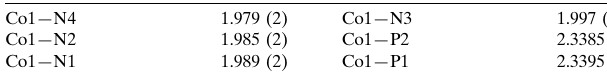
Selected geometric parameters (A˚ , (cid:2)